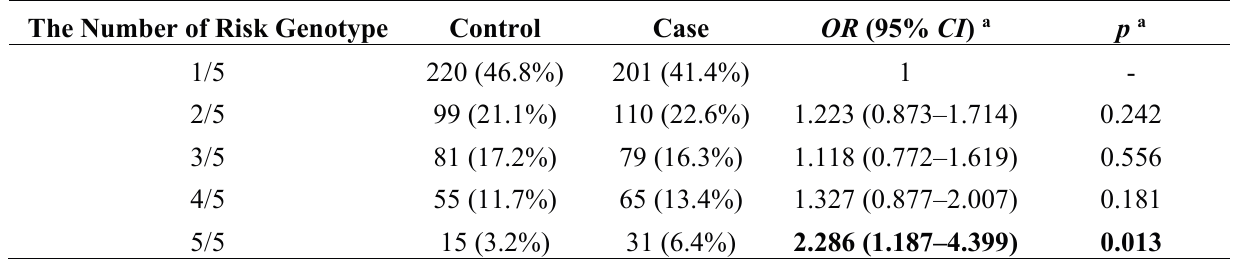
Table 6. Cumulative risk of five susceptibility SNPs for breast cancer.